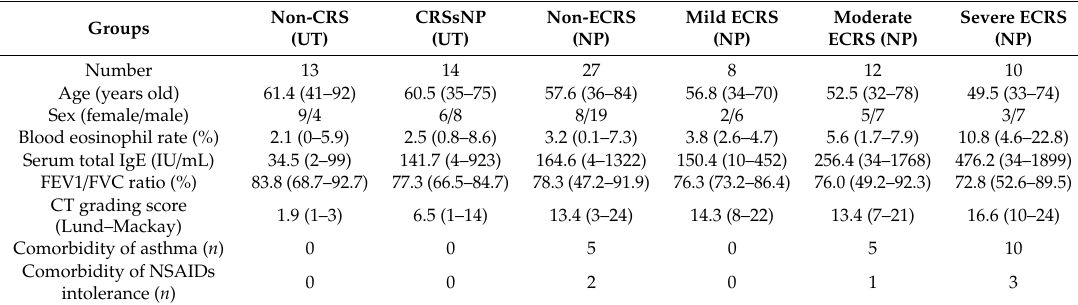
Table 1. Subjects’ characteristics.